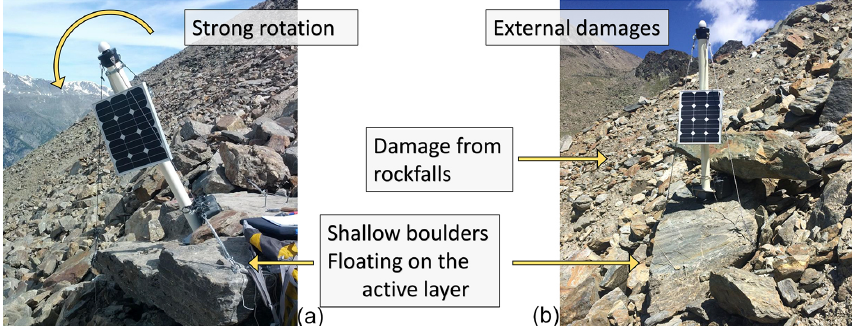
Figure A7. In very active movement zones finding a single block to fix the measurement instrument can be challenging, both w.r.t. longevity and the representative motion of the investigated landform. The two locations shown in this figure are very active zones in steep parts of two rock glaciers above Herbriggen (Switzerland): Dirru rock glacier (a) and Breithorn/Bielzug rock glacier (b) . Photos from PermaSense archive.